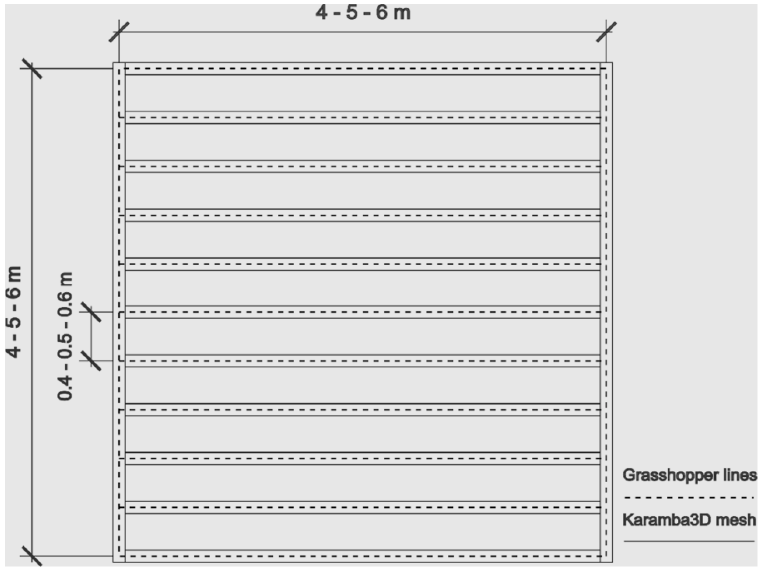
Figure 2. Geometry parameters of the quadrangular structure.